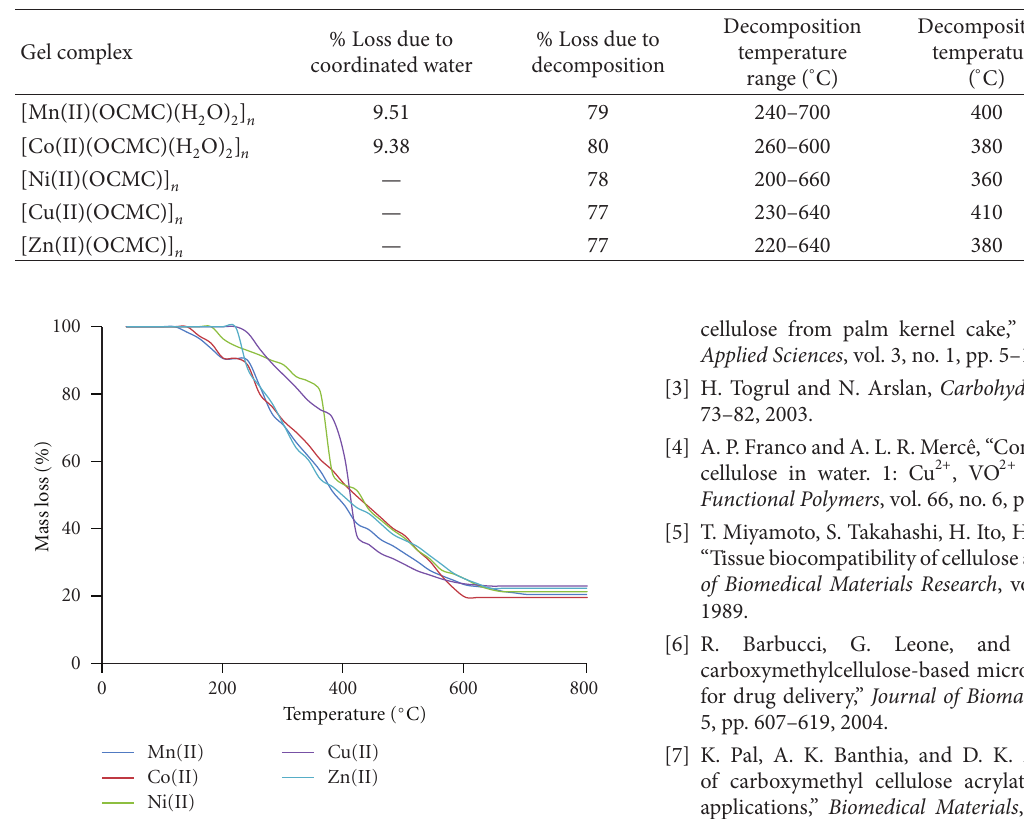
T 5: ermoanalytical data of OCMC Metallic Gel complexes.